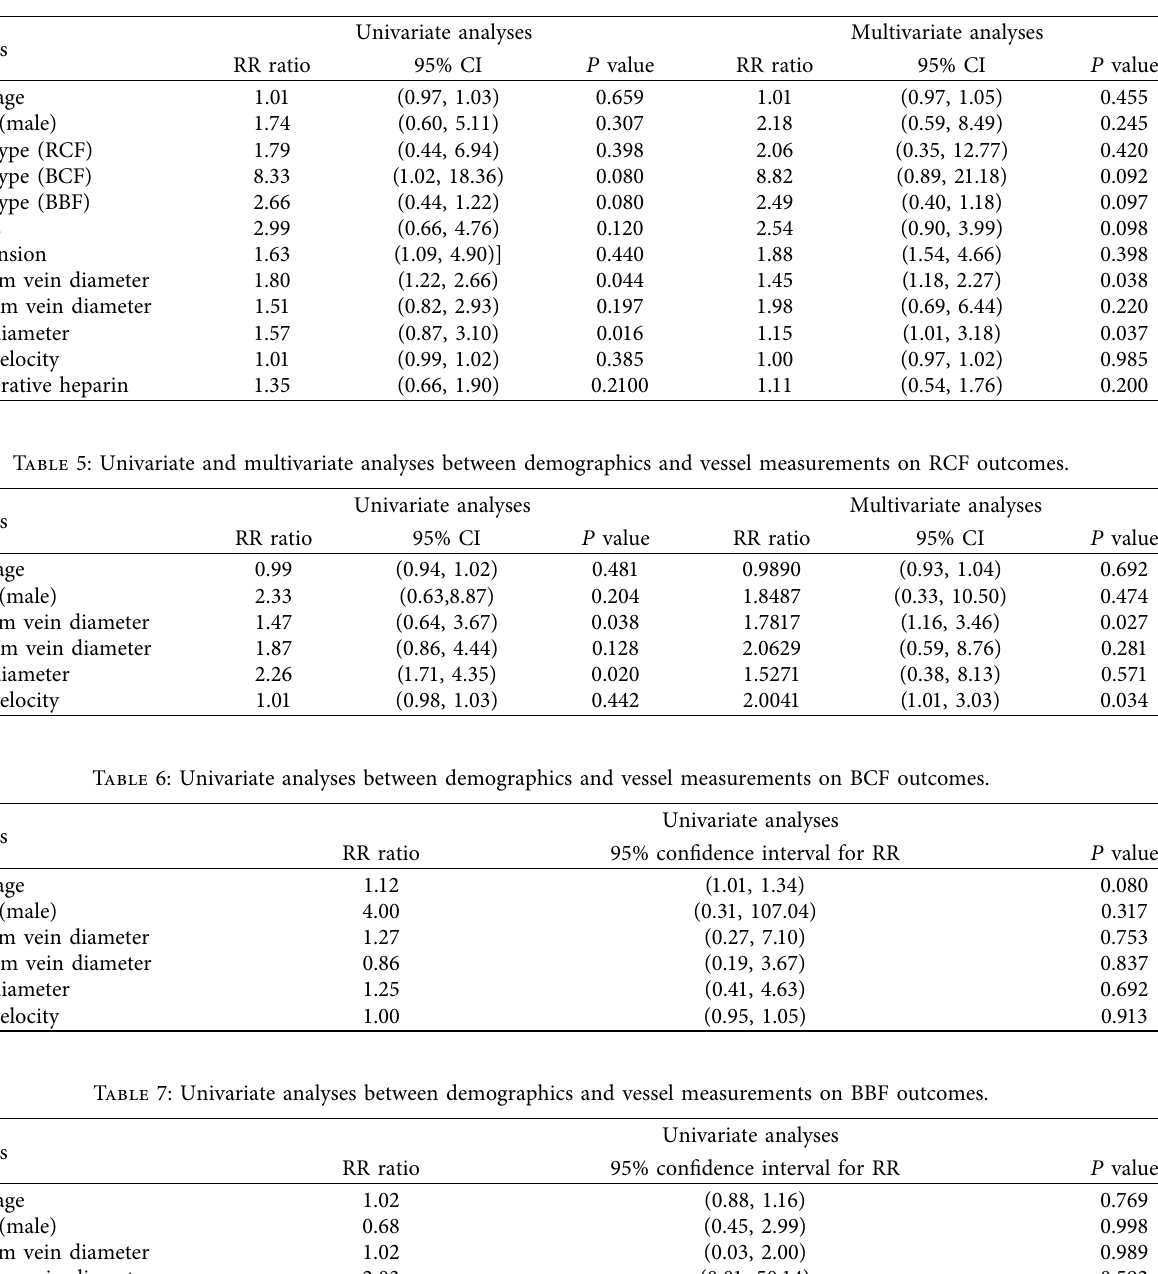
Table 4: Univariate and multivariate analyses between demographics, fistula type, comorbidities, vessel measurements and heparin use, and AVF outcomes.